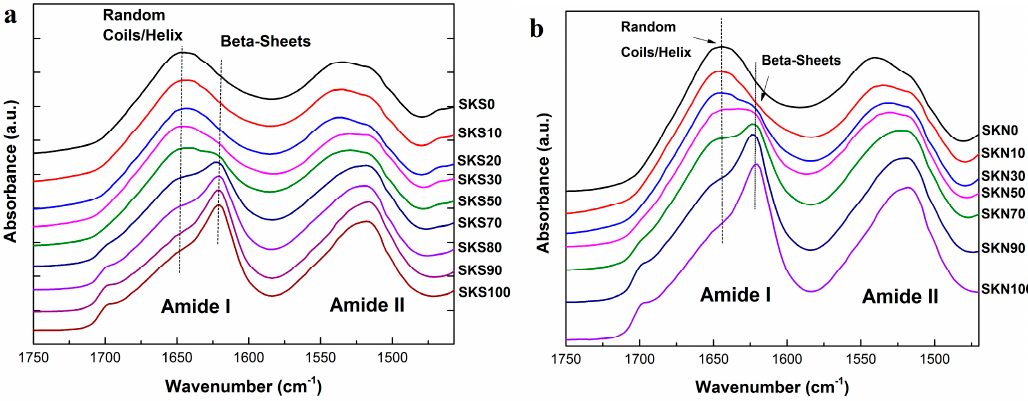
Figure 1. FTIR absorbance spectra of various silk-keratin samples: ( a ) ultrasonication-induced hydrogel/aggregate systems (SKS0, SKS10, SKS30, SKS50, SKS70, SKS80, SKS90, SKS100); ( b ) naturally self-assembled hydrogel/aggregate systems (SKN0, SKN10, SKN30, SKN50, SKN70, SKN90,